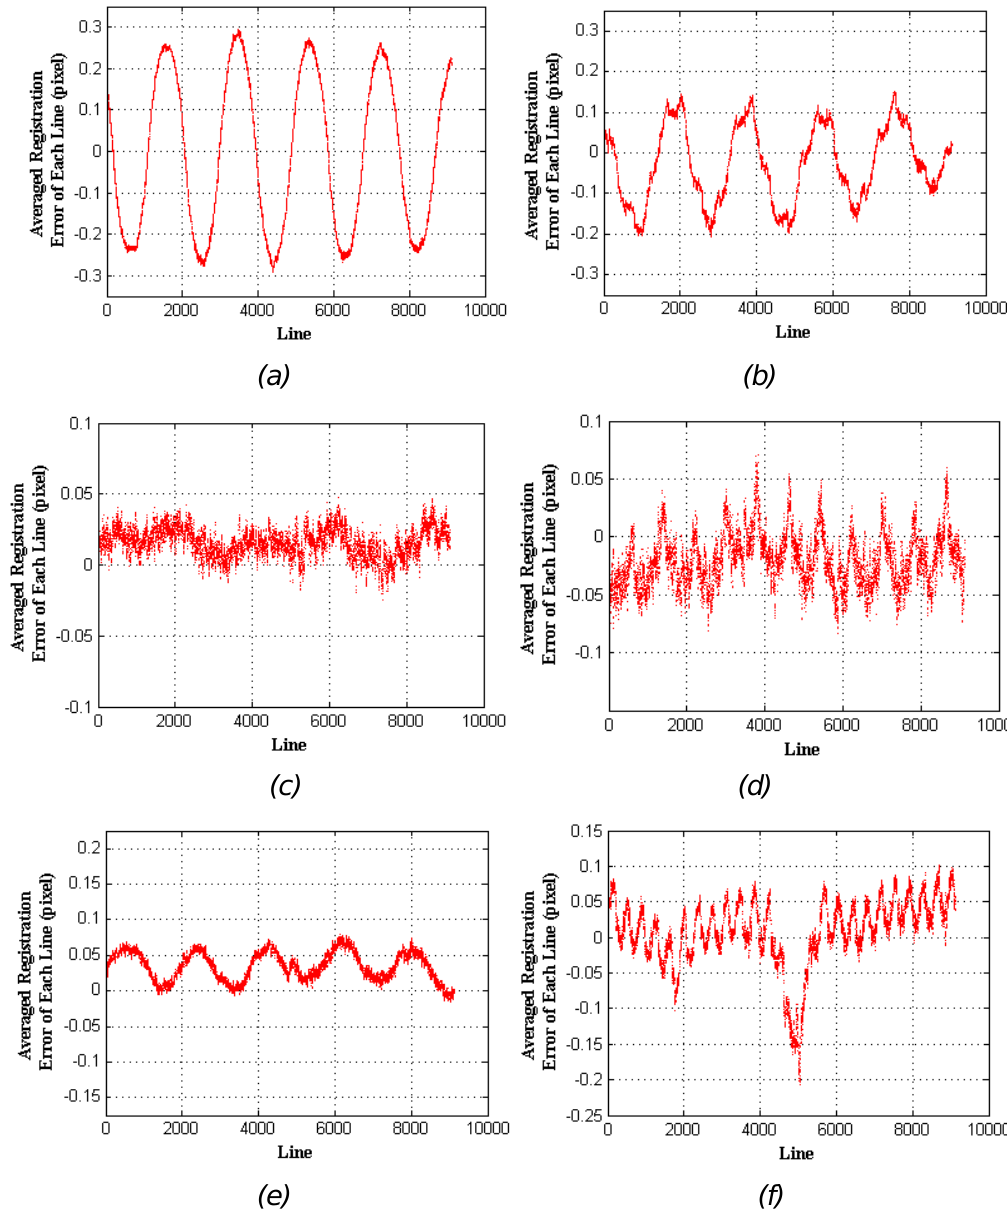
Figure 5. The jitter detection curve. (a), (c), (e) are error curves in sample direction of dataset 1, 2, 3; (b), (d), (f) are error curves in line direction of dataset 1, 2,